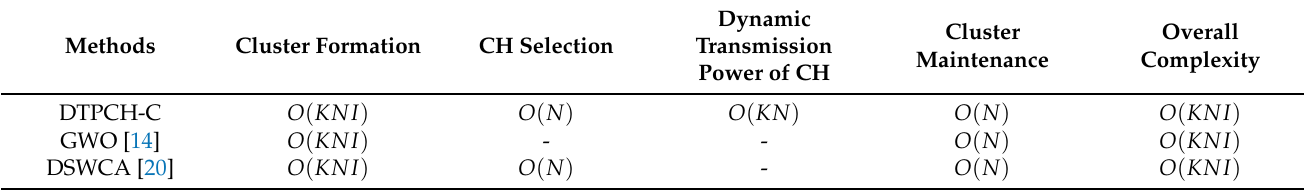
Table 6. Time complexity